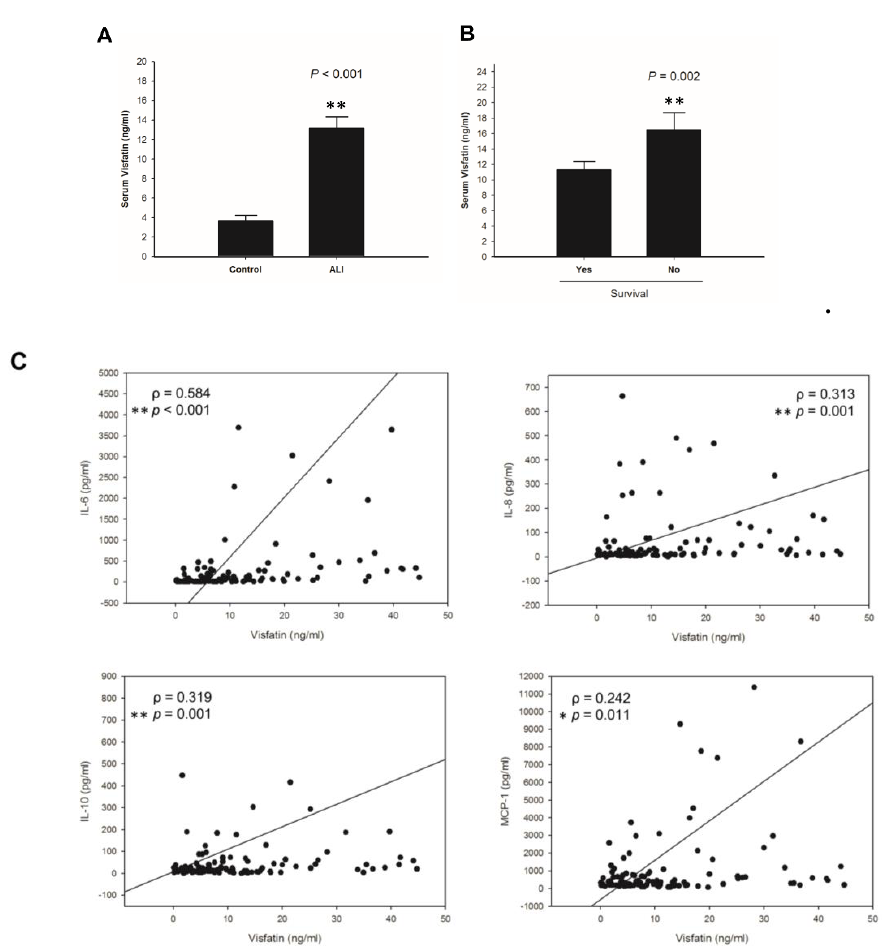
Figure 1. Upregulation of serum visfatin in acute lung injury (ALI) patients. ( A ) Serum visfatin levels in ALI patients ( n = 110) and normal controls ( n = 32). ( B ) Correlation of patient survival with serum visfatin levels. ( C ) Spearman’s correlation of serum visfatin with IL-6, IL-8, IL-10, and MCP-1 in ALI patients. Results are mean ± SD. *, p value < 0.05. **, p value <